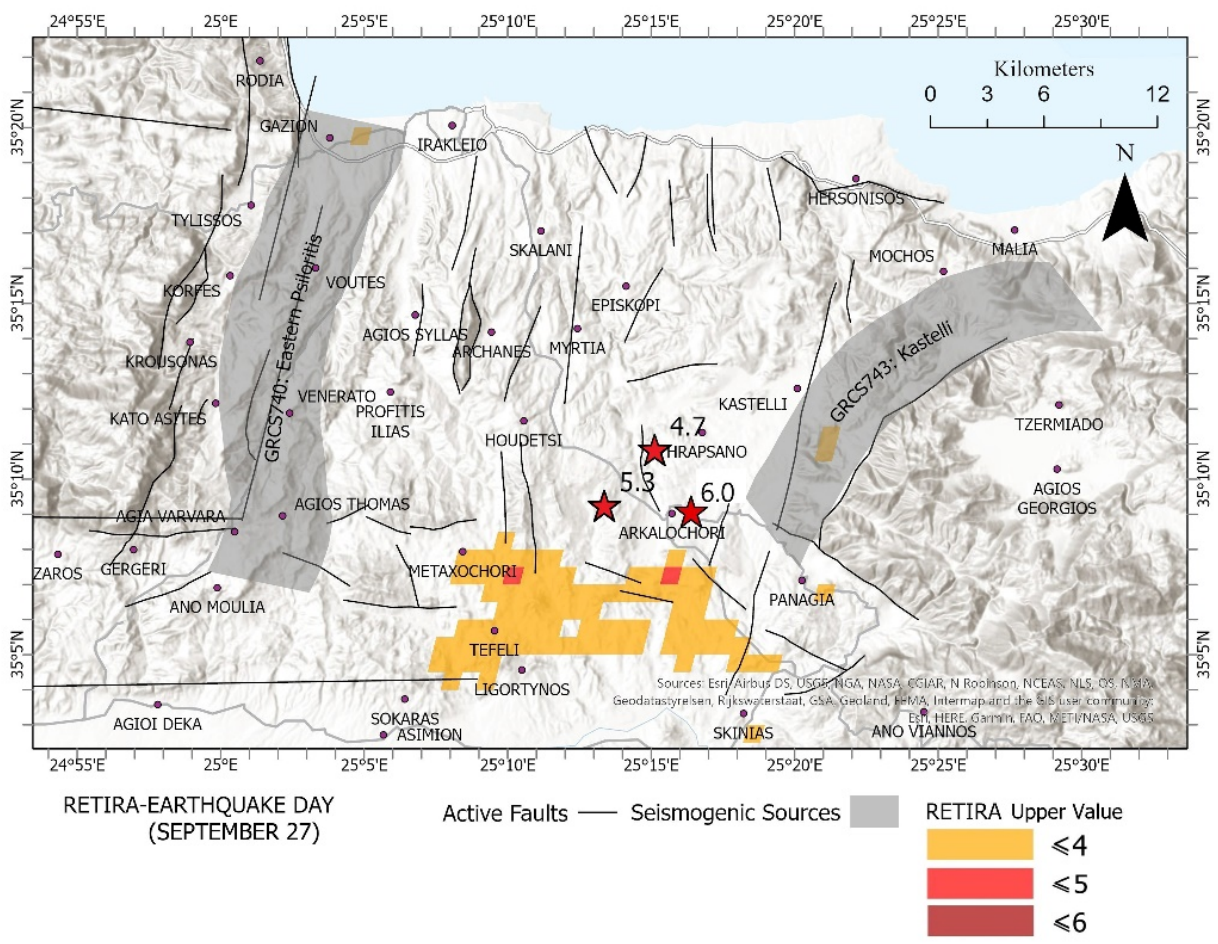
Figure 4. Pre-seismic and co-seismic (last image) RETIRA thermal anomalies of the broader earth- quake area of Central Crete occurring during September 2021. The epicenters of the main event and of the two major aftershocks are shown with red stars.